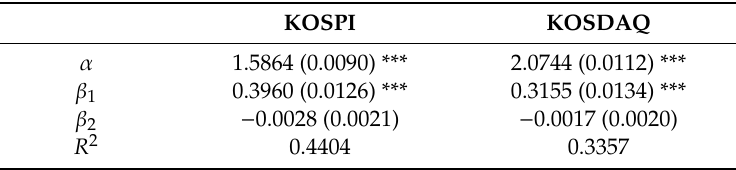
Table 2. Estimates of herding behavior without market conditions.